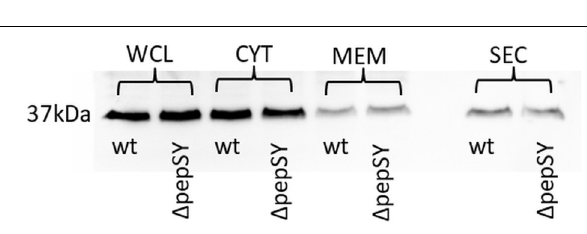
FIGURE 4 | In vitro proliferation of (cid:49) pepSY and wt FSC200 in BMMs (A) . The cells were infected at multiplicity of infection 50:1 with the indicated strains. BMMs were harvested at 1, 6, 24, and 48 h. The data shown are means ± SD of triplicate samples and the results shown are representatives of three independent experiments. Survival of mice infected with (cid:49) pepSY mutant (B) . Groups of five BALB/c mice were infected subcutaneously with the wt and (cid:49) pepSY mutant using a dose of 10 2 CFU/mouse, the control group was inoculated with sterile saline.